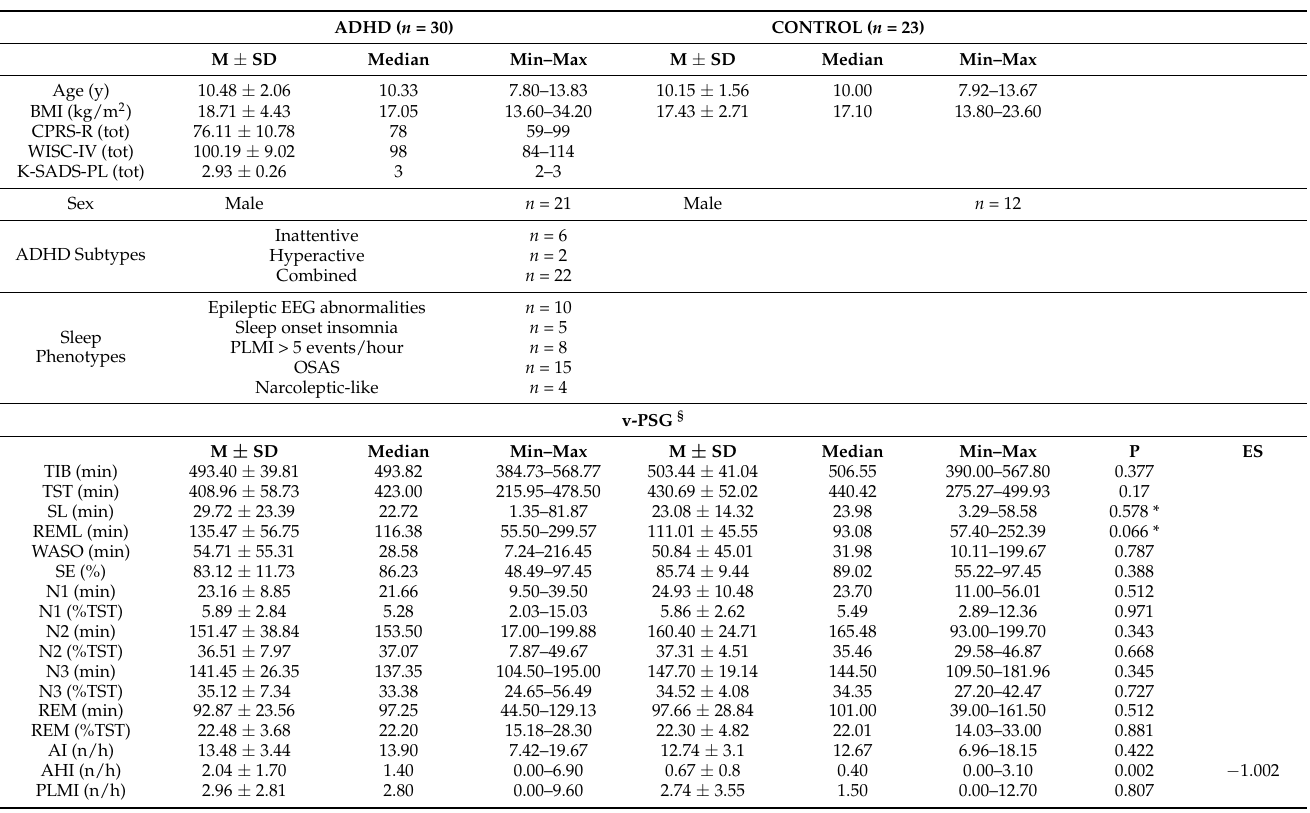
Table 1. Clinical and instrumental sleep data in the attention-deficit/hyperactivity disorder (ADHD) group and in the healthy control